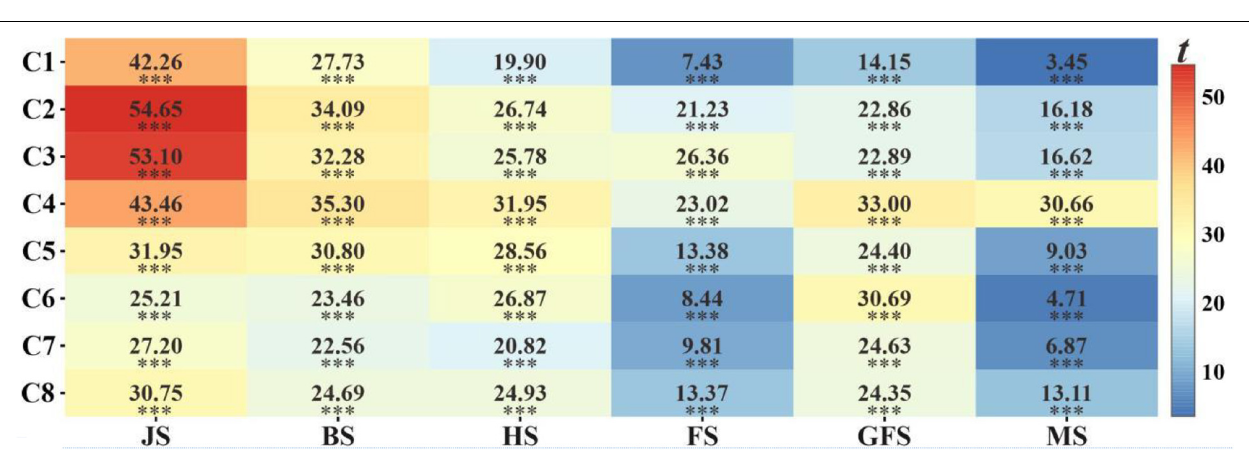
results in this study show that GRA can reduce the dimensionality of the input features to some